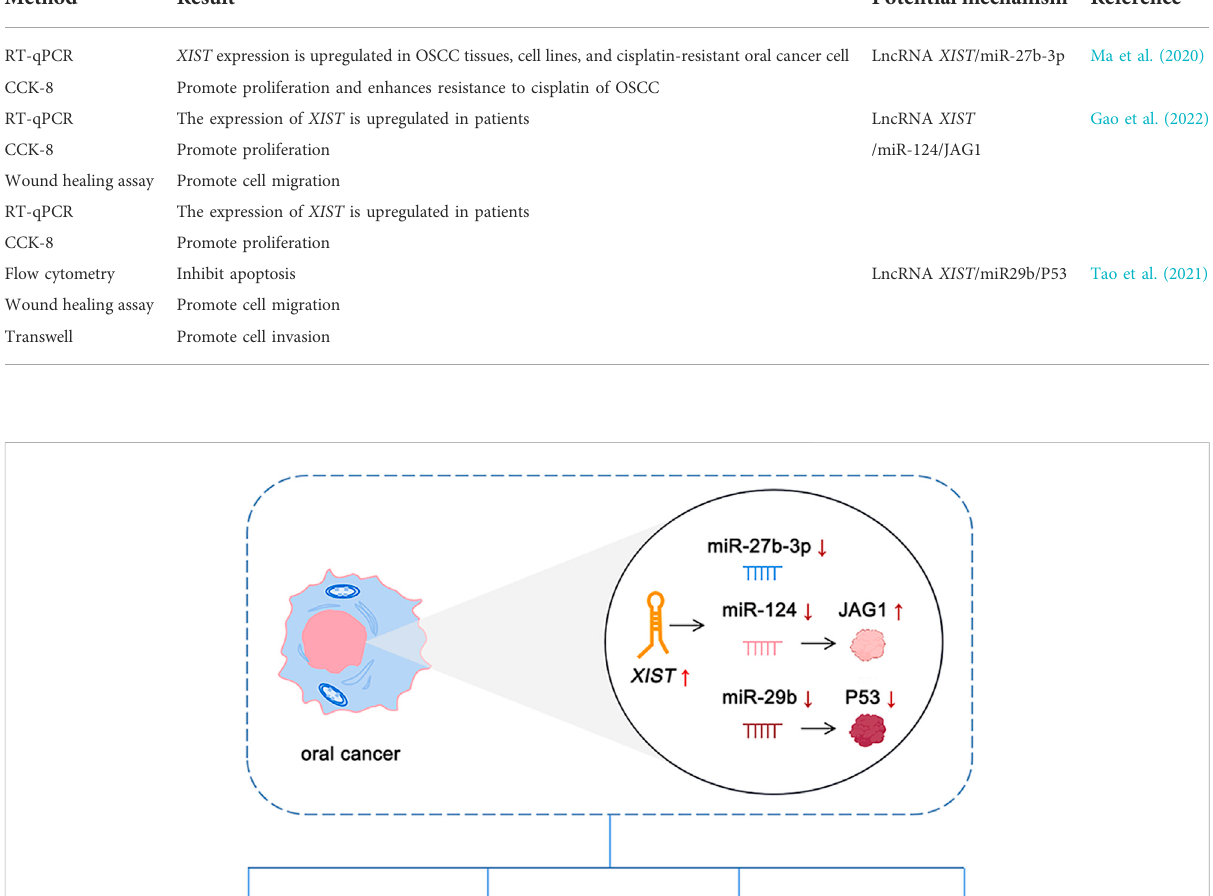
TABLE 1 Potential role of XIST in oral cancer.